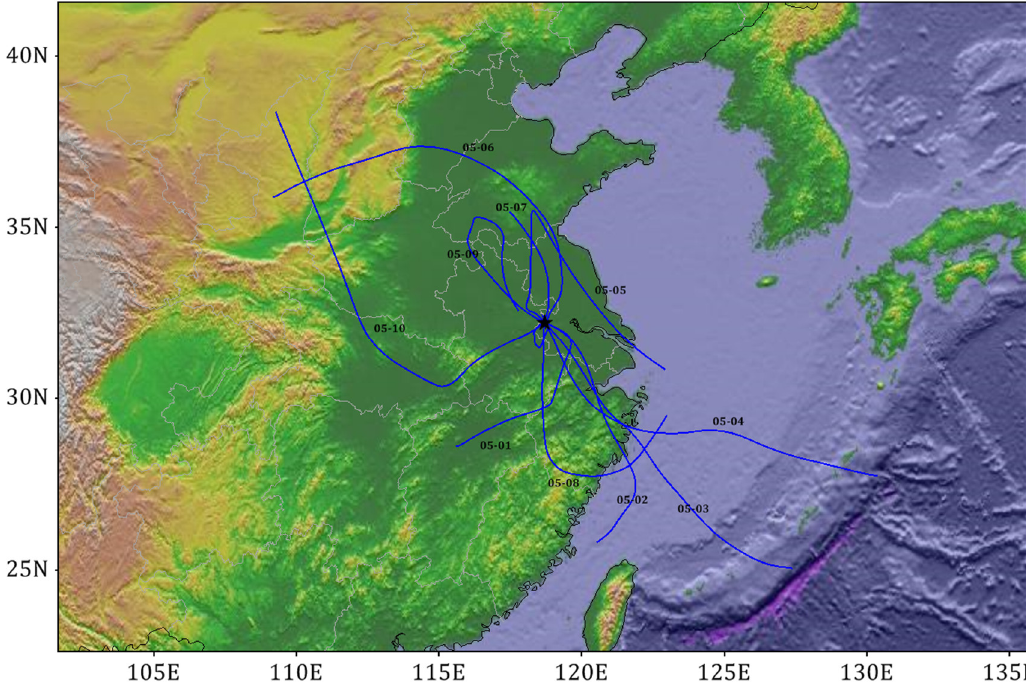
Figure 1. Site information and the daily backward trajectories at 12:00 LST and 1000 m a.s.l. during the observation periods.